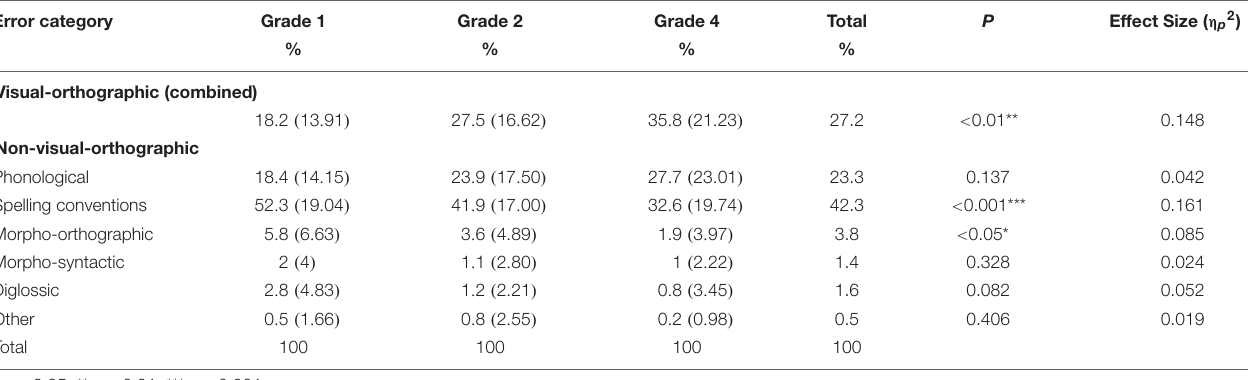
TABLE 3 | Means (in percentages) and standard deviations (in parentheses) of error rates for the combined visual-orthographic category and the six additional categories at three grade levels.